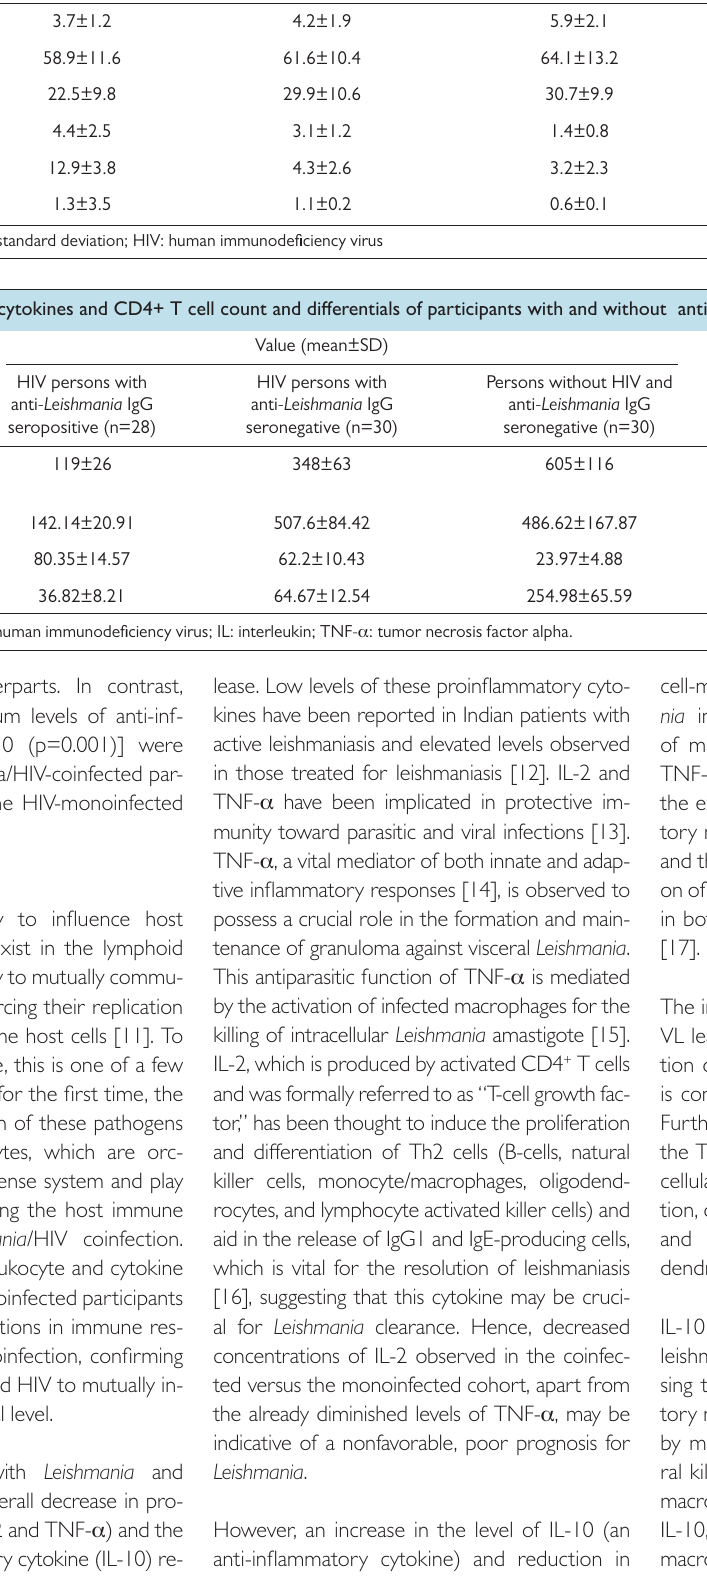
Table 2. Comparison of white cell count and differentials of participants with and without anti-Leishmania IgG Value (mean±SD) HIV persons with HIV persons with Persons without HIV and anti- Leishmania IgG anti- Leishmania IgG anti- Leishmania IgG Parameter